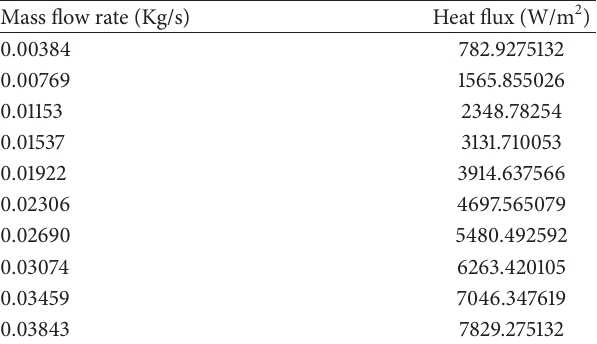
Table 3: Numerical values of the parameters used for simulation. Mass flow rate (Kg/s) Heat flux (W/m 2 )